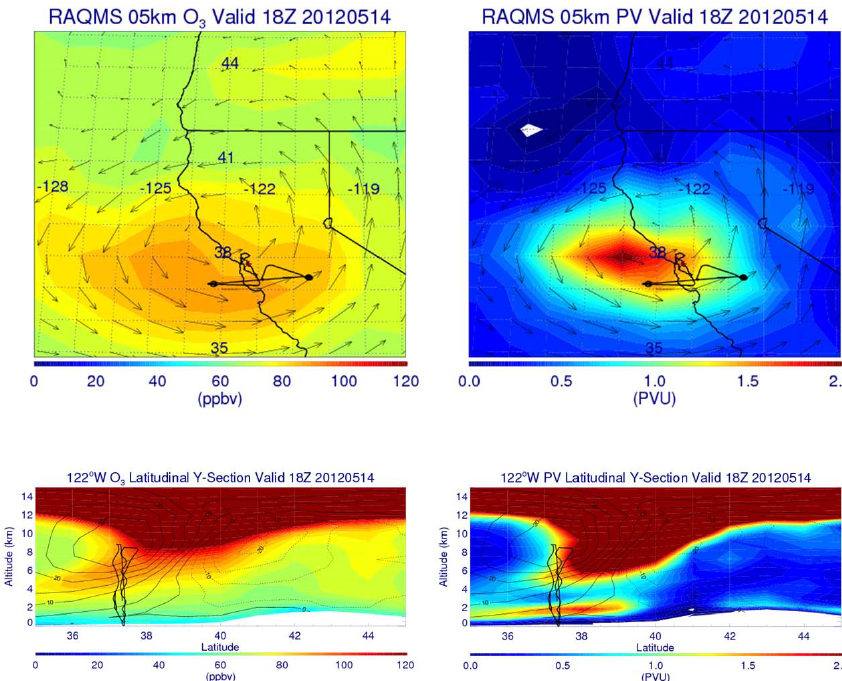
Fig. 2. 5km O 3 (ppbv) and wind vector (black, upper left) and PV (PVU) and wind vector (black, upper right) maps with O 3 (ppbv, lower left) and PV (PVU, lower right) cross sections at 122 ◦ W on 14 May 2012 at 18:00UTC from the RAQMS analyses. The aircraft flight track is shown in black. Oakland, located on the San Francisco East Bay, is shown as a red star. Note the cutoff low associated with relatively strong PV (bottom right) and high O 3 (bottom left) extending from the lower stratosphere into the mid-troposphere. The flight track and observations were taken in a region were PV is <2PVU (bottom right), indicating STT occurrence (i.e., stratospheric air was sampled after crossing the tropopause). Black contours represent wind speed in ms − 1 .